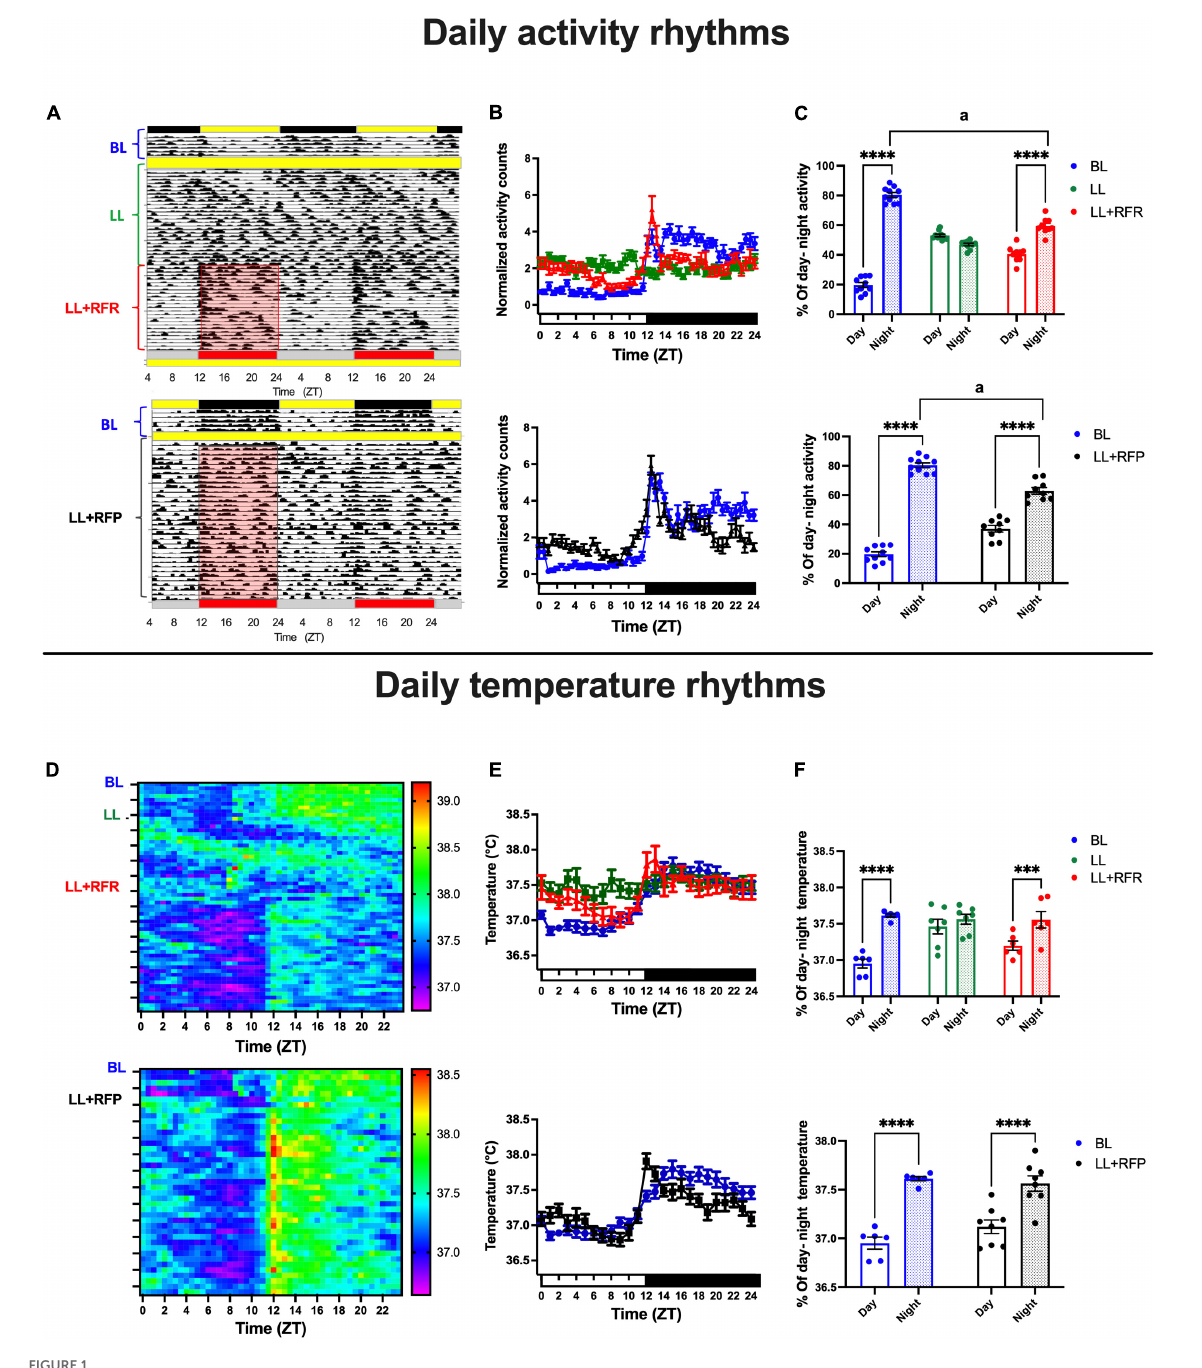
FIGURE1 Daily activity and core temperature cycles in rats exposed to a light–dark cycle during the baseline (BL, blue lines and bars), to constant light (LL, green line and green bars), to LL followed by 3 weeks of the 12-h restricted feeding schedule as a rescue strategy (LL + RFR, red), or to LL paired simultaneously to the 12-h restricted feeding schedule as a preventive strategy for 6 weeks (LL + RFP, black). (A top) Representative actogram for the BL, LL, and the LL + RFR condition. (A bottom) Representative actogram for the BL, LL, and the LL + RFR condition. (B top and bottom) Daily activity patterns for the different experimental conditions. Data are expressed as the mean ± SEM; n = 9–10/group. (C top and bottom) Day–night percentage of activity for the experimental stages; light bars represent day, and dashed bars represent night. (D top) Mean heat map for BL, LL, and LL + RFR conditions. (D bottom) Mean heat map for the BL and LL + RFP conditions. (E top and bottom) Daily temperature patterns for the different experimental conditions; data are expressed as the mean ± SEM; n = 6–11/group. (F top and bottom) Day–night mean values for core temperature for the experimental stages; light bars represent day, and dashed bars represent night. Asterisk indicates a statistical difference between the day and the night value/group **** = ( P < 0.0001). The letter a indicates a statistical difference between the nights of each group, a = ( P <